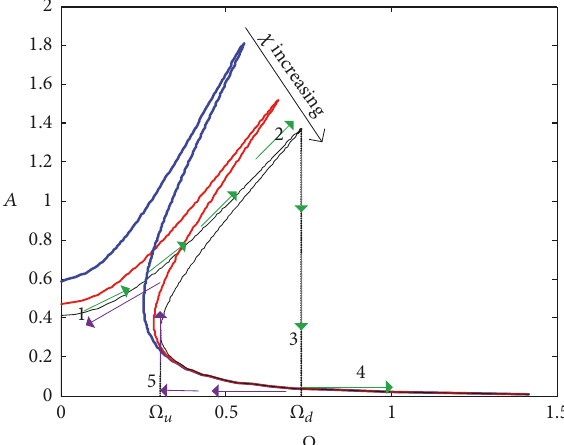
Figure 11: Theinfluence of the nonlinear term of quasi-zero stiffness on the 𝐴 - Ω